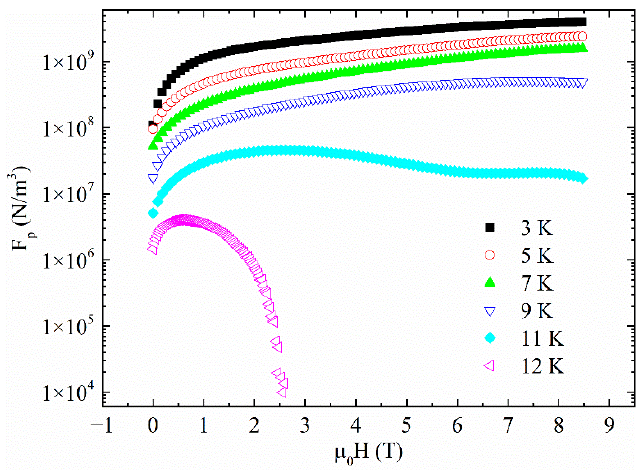
Figure 7. Pinning force density as a function of field at different temperatures.